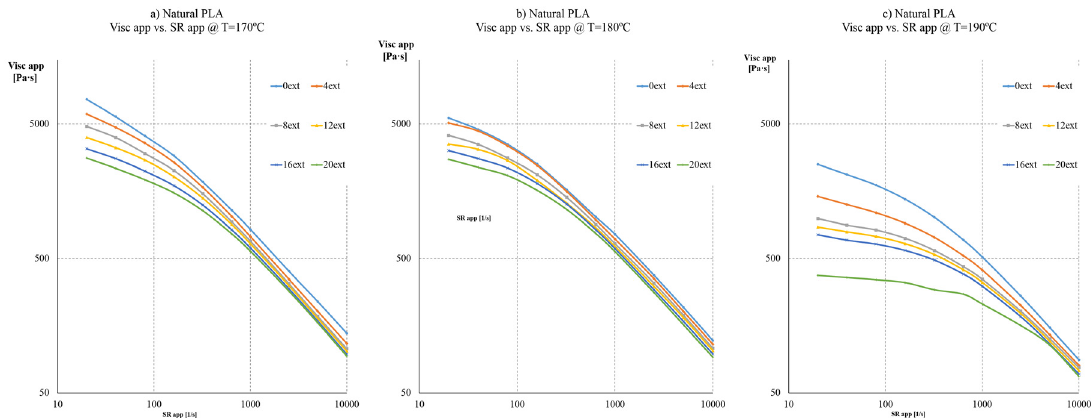
Figure 3. Apparent viscosity curves at different apparent Shear rates of each extrusion sample for: ( a ) Natural PLA at 170 ˝ C; ( b ) Natural PLA at 180 ˝ C; ( c ) Natural PLA at 190 ˝ ( a ) Natural PLA at 170 °C; ( b ) Natural PLA at 180 °C; ( c ) Natural PLA at 190 °C.